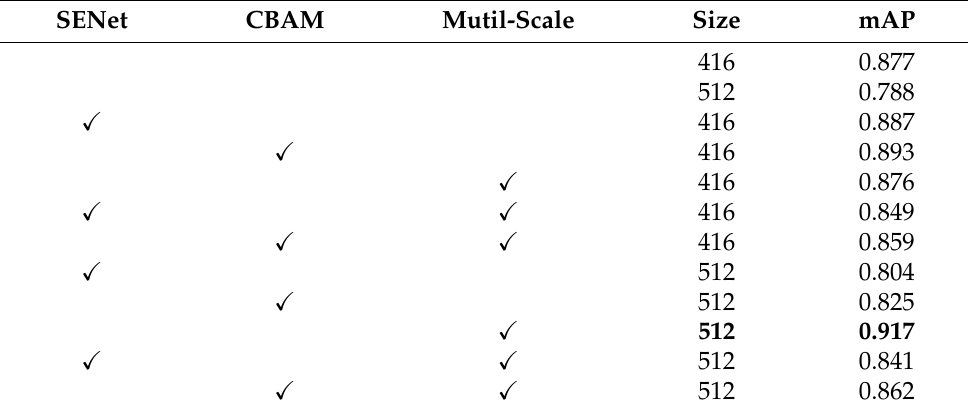
Table 1. The results of all comparative experiments.